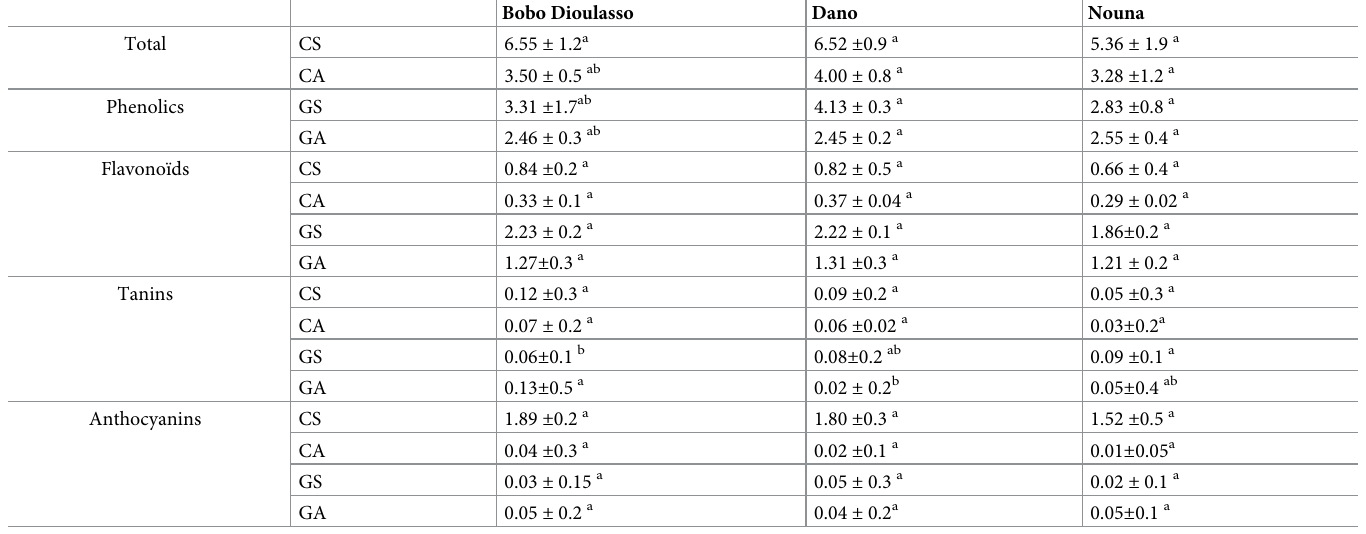
Table 3. Effect of production areas on bioactive